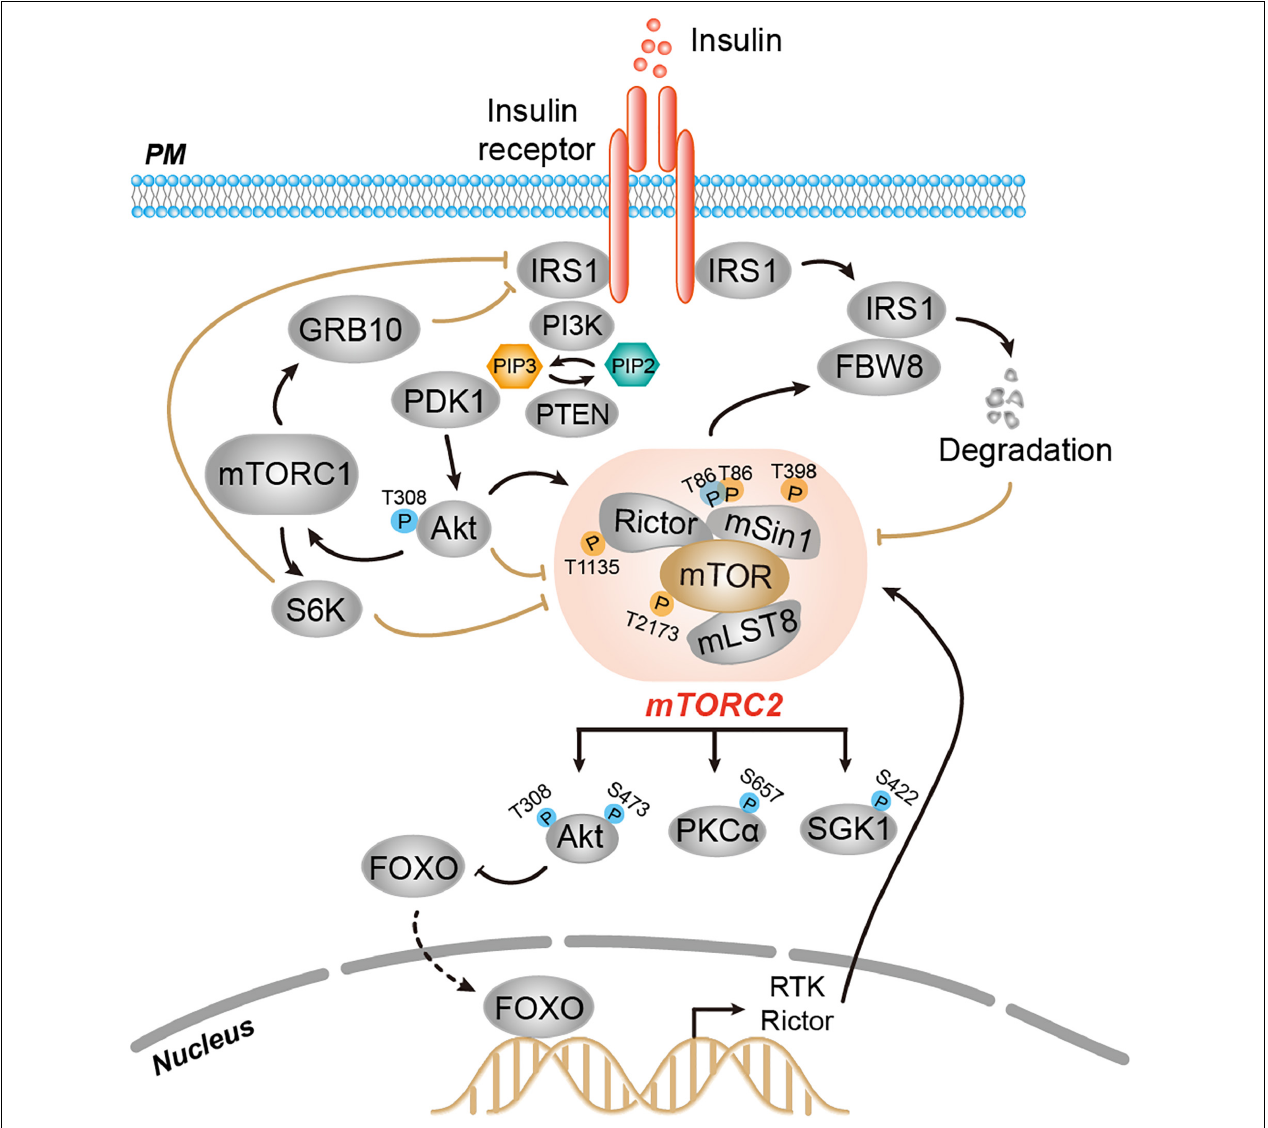
FIGURE 2 | Feedback regulation of mTORC2 activity. Several downstream signals of mTORC2, such as FBW8-IRS, mTORC1-GRB10-IRS, mTORC1-S6K-IRS, Akt, and FoxO, function as negative or positive regulators that impact mTORC2 signaling relay. Upon insulin stimulation, mTORC2 phosphorylates FBW8 to allow the translocation of FBW8 to the cytosol, which mediates ubiquitylation and proteasomal degradation of IRS1, thereby preventing chronic insulin signaling and mTORC2 activation. Insulin-induced mTORC1 phosphorylates and activates Grb10 to inhibit mTORC2 and Akt downstream. The mTORC1 effector S6K1 promotes phosphorylation-dependent degradation of IRS or phosphorylation of Rictor-T1135 and mSin1-T86/398 to dampen mTORC2 signaling. Akt promotes mTOR-T2173 phosphorylation to impair mTORC2 activity. Akt also positively regulates mTORC2 activity by phosphorylating mSin1-T86. Prolonged inhibition of Akt promotes FOXO-dependent transcription of RTK and